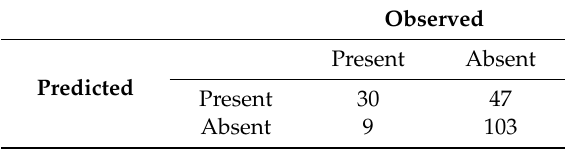
Table A13. Categorical muddy / sandy S-LOO CV error matrix with threshold of occurrence set to